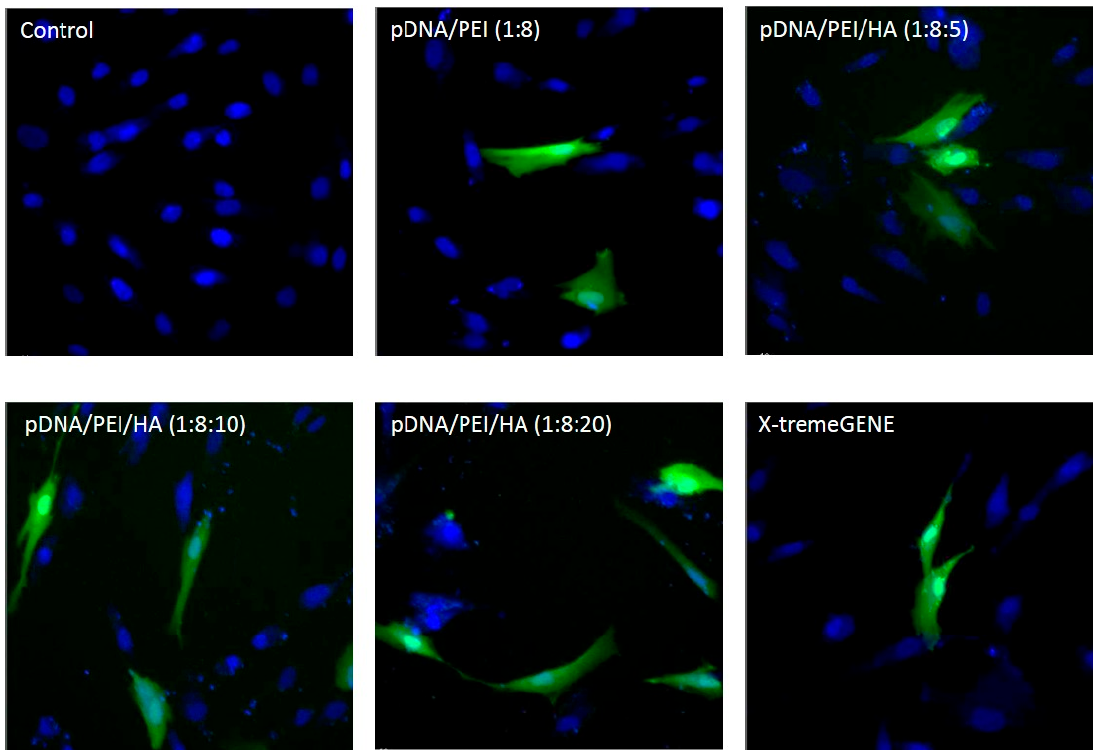
Figure 6. Fluorescence images of hASCs after transfection with each nanocomplex at 24 h. (Ex 490/20 and 360/40; Em 526/36 and 455/50).